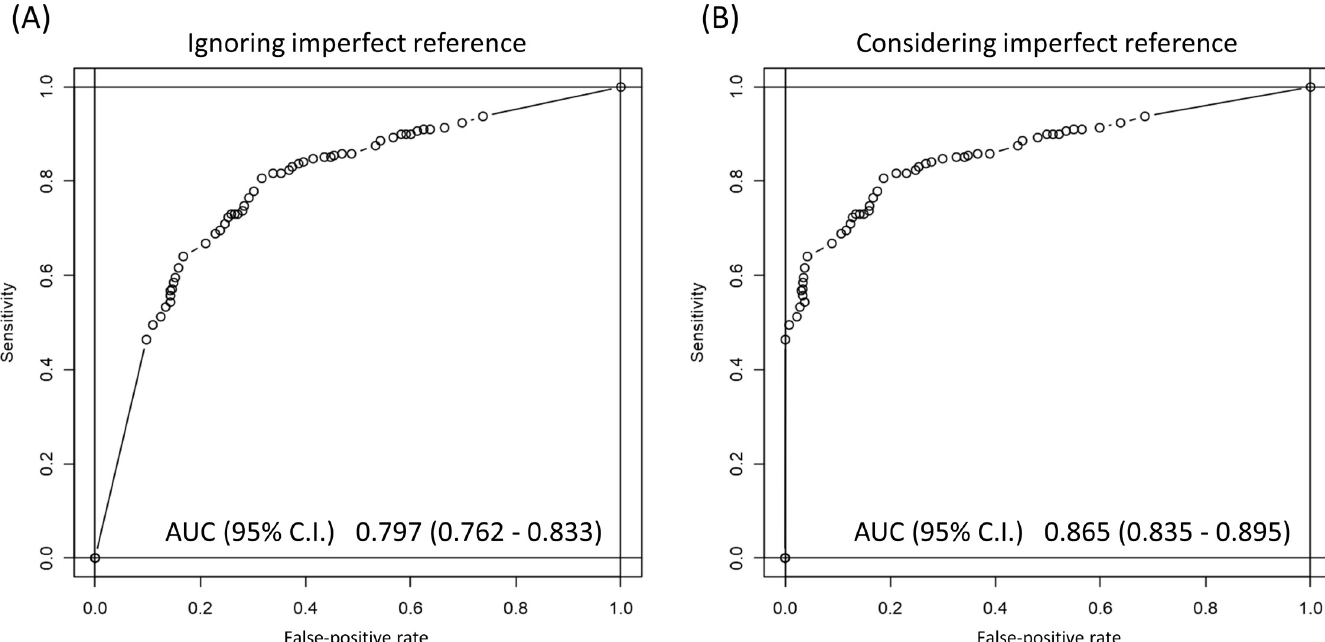
Fig 3. Relationship between the test performance and the number of days after the onset of symptoms. (A) The graph shows the relationship between the test performance and the number of days after the onset of symptoms when the confidence score from Ali-M3 is at 0.20. (B) The graph shows the relationship between the test performance and the number of days after onset of symptoms when the confidence score from Ali-M3 is at 0.50. The light gray bar shows the number of patients included in the strata of days after the onset of symptoms, following the right axis. One stratum includes 2 days from day 0 to day 13. The stratum to the extreme right includes 14 days or more. Following the left axis, the solid lines represent the sensitivity in strata, and the dash lines represent specificity in the strata.